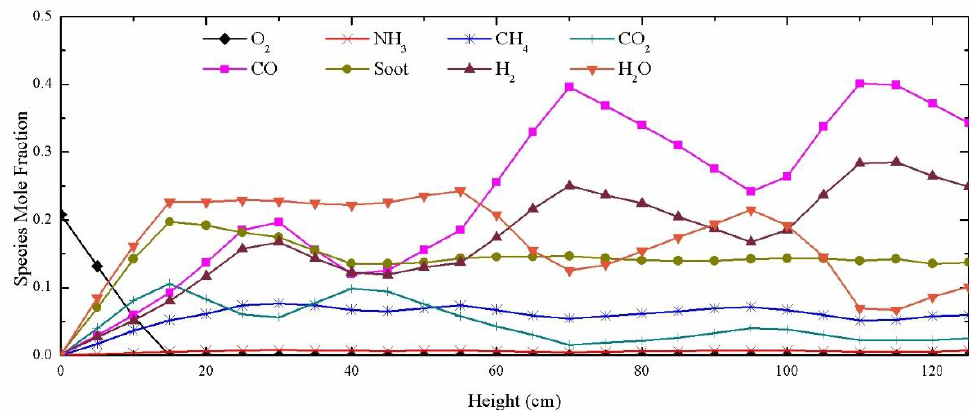
Figure 5. Distribution of molarity concentration of each component along with height (ER = 0.2; T = 1000 K).